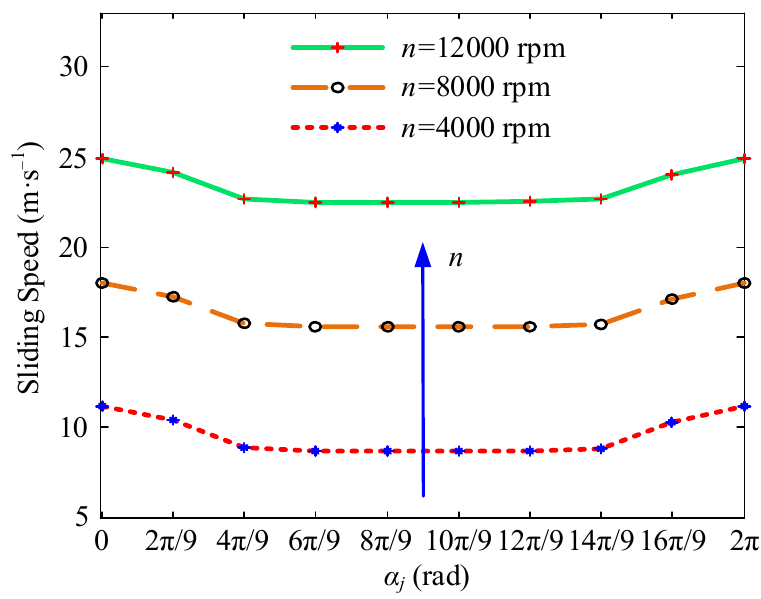
Figure 9. Sliding speed between the ball and the inner raceway at different speeds.